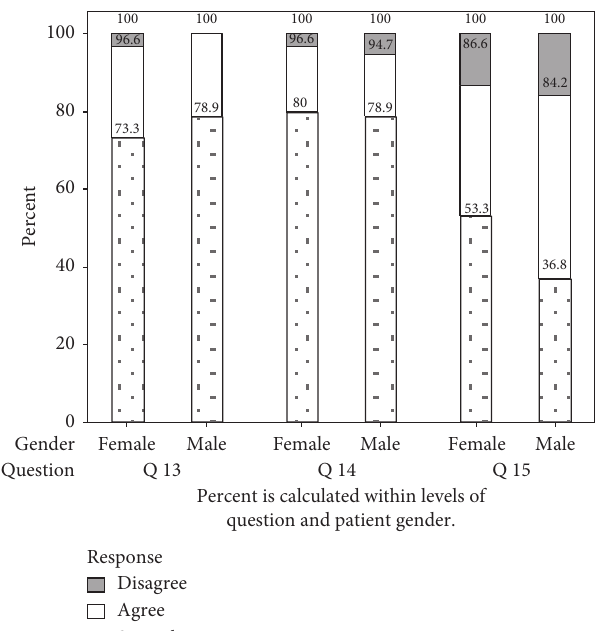
Figure 3: Overall level of satisfaction for statements